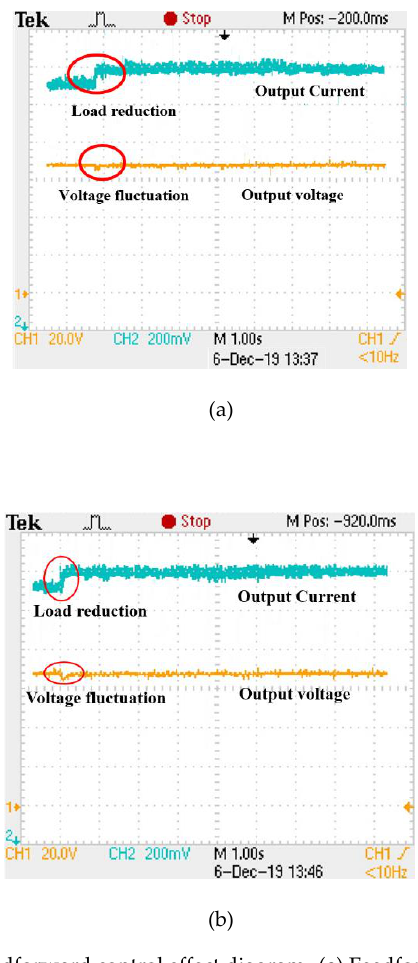
Figure 18. With or without feedforward control effect diagram. ( a ) Feedforward dual closed-loop control output waveform. ( b ) Output waveform without feedforward control.